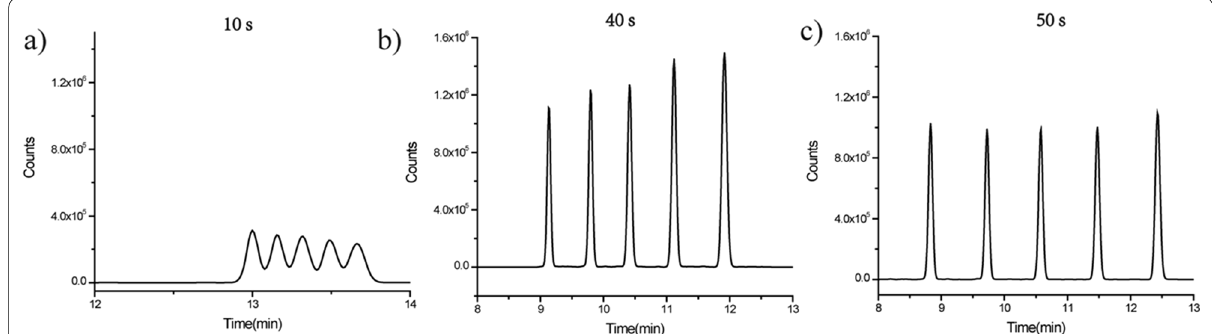
Fig. 3 Effects of time intervals on separation, the injection space–time was a 10 s, b 40 s, c 50 s, respectively, taking Cys as an example